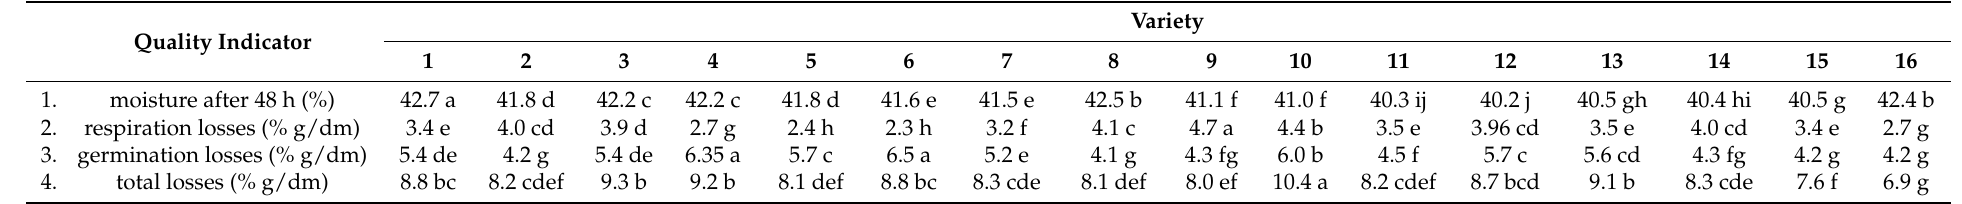
Table 7. Results of micromalting analysis (procedure